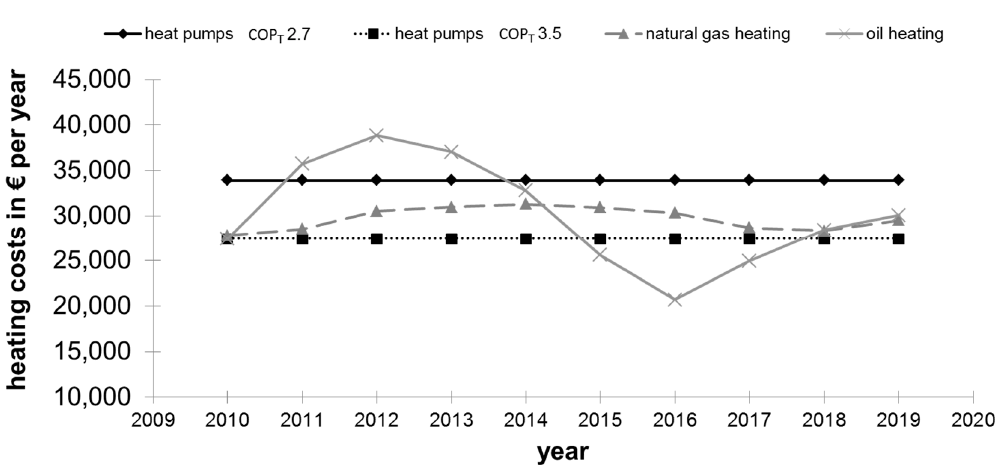
Figure 8. A comparison of the annual heating costs for four different heating systems (a groundwater heat pump with a COP T of 2.7, a groundwater heat pump with a COP T of 3.5, a natural gas heating system and an oil heating system) over the last 10 years. The only variable factor is the energy price (annual average) for oil and natural gas.